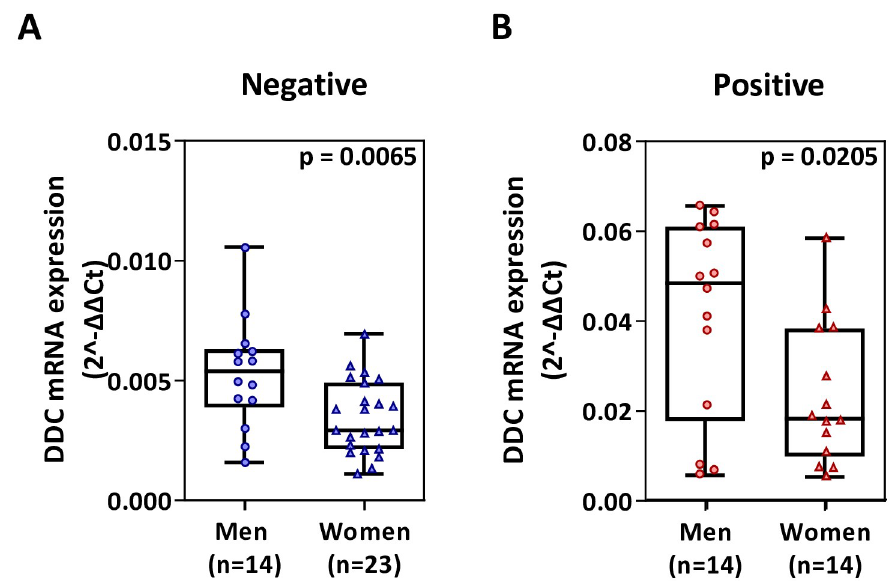
Fig 2. Relative DDC mRNA expression in men as compared to women in non-infected (A) and SARS-CoV- 2-infected (B) groups. Data are represented as box plots; line in the middle, median; box edges, 25 th to 75 th centiles; whiskers, range of values. p values were calculated with student’s